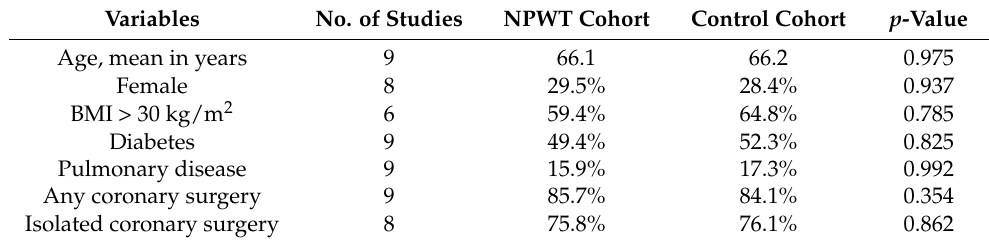
Table 2. Pooled characteristics of patients of the included